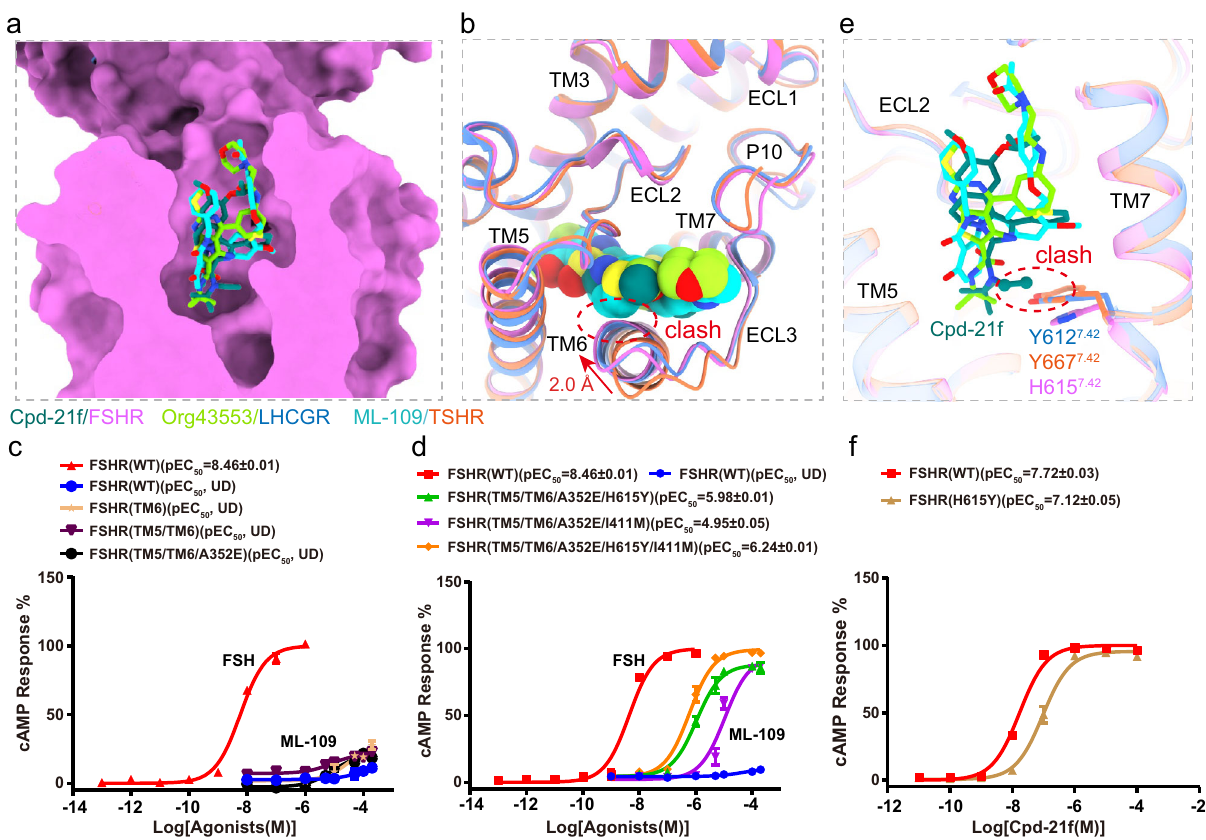
Fig. 5 | Structural basis of allosteric agonist selectivity for FSHR. a Structural comparison of Cpd-21f binding pocket in the FSH-FSHR-Gs complex with the Org43553 binding pocket in the CG-LHCGR-Gs complex, and ML-109 binding pocket in the TSH-TSHR-Gs complex. b Structural comparison of the binding pockets in FSHR and LHCGR TMDs. The clashes between ML-109 and the extra- cellular side of TM6 of FSHR and LHCGR are highlighted in red circles. The shift between FSHR TM6 and TSHR TM6 was measured at residues S594 in FSHR and S646 in TSHR. c , d Concentration-response curves for WT and mutated FSHR. The representative concentration-response curves from three independent experi- ments were shown. WT refers to wild type receptor; TM6 means swapping of the extracellularportionofFSHRTM6(residues591 – 599)withthecorrespondingTSHR TM6 region (residues 643 – 651); TM5/TM6 means the replacement of the extra- cellularportionsofbothTM5andTM6fromFSHR(residues527 – 536/591 – 599)with